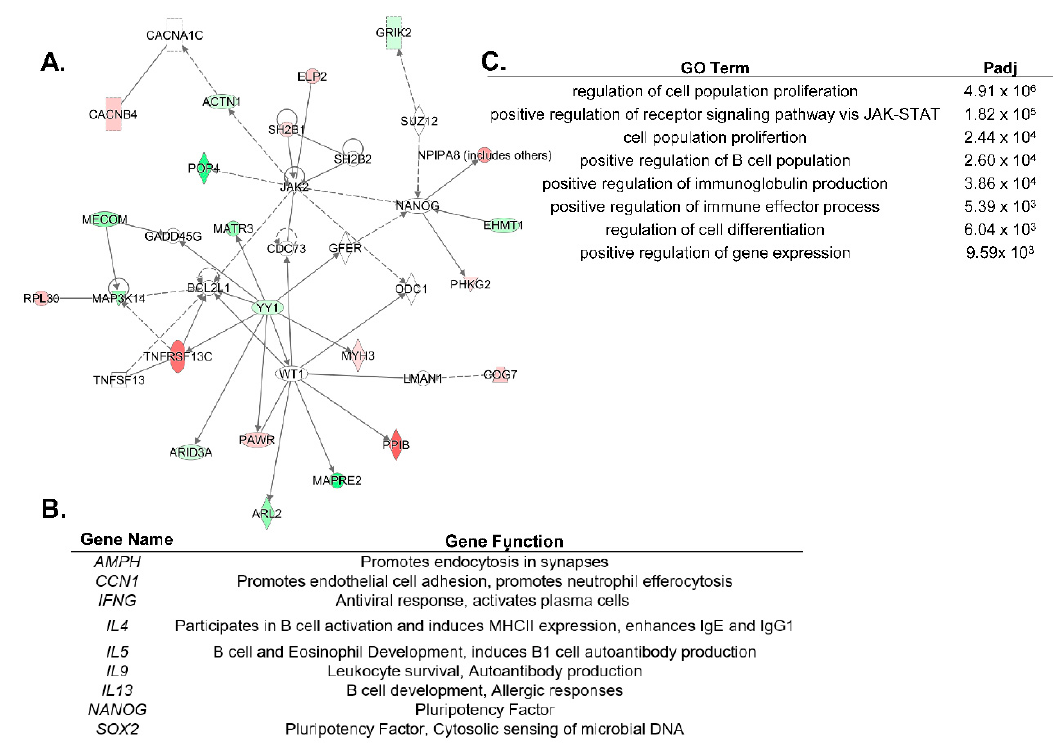
Figure 3. ARID3a expression is associated with diverse genes in distinct cell types. ( A ). An ingenuity pathway analysis (IPA) network was generated using genes di ff erentially expressed in single cell RNAseq of naïve SLE B cells with a di ff erential ARID3a expression. Green indicates upregulation and red indicates downregulation, while the genes associated with these pathways, but not di ff erentially regulated in the B cells, are colorless. ( B ). SLE LDNs and pDCs shared nine di ff erentially expressed genes associated with the ARID3a expression and listed here. ( C ). GO analyses of the nine ARID3a-associated genes di ff erentially regulated in both pDCs and LDNs indicate the most significant pathways associated with their expression.